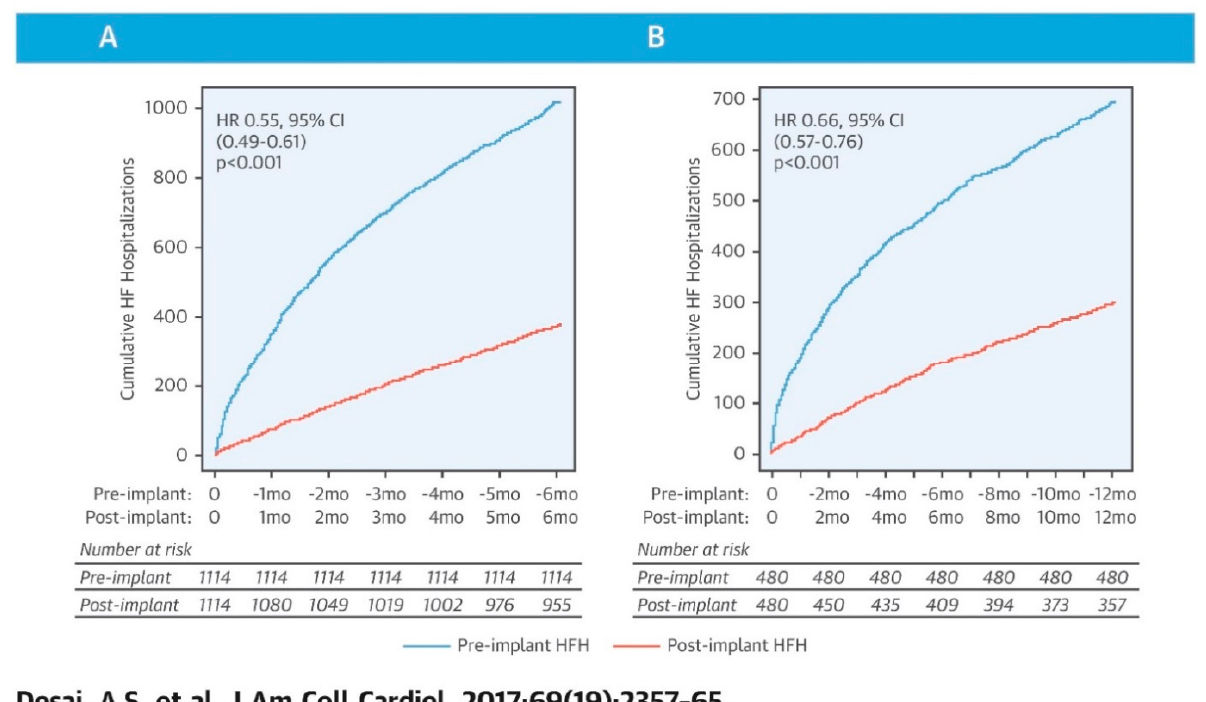
Figure 7. Heart failure hospitalization (HFH) rates before and after pulmonary artery pressure sensor implantation as reported in the CardioMEMS Post-Approval-Study. ( A ) 6 month cohort, ( B ) 12 month cohort. Reprinted from the Journal of the American College of Cardiology, Volume 69, Issue 19, Desai et al., Ambulatory Hemodynamic Monitoring Reduces Heart Failure Hospitalizations in “Real-World” Clinical Practice, pages 2357–2365, Copyright 2017, with permission from Elsevier [9].